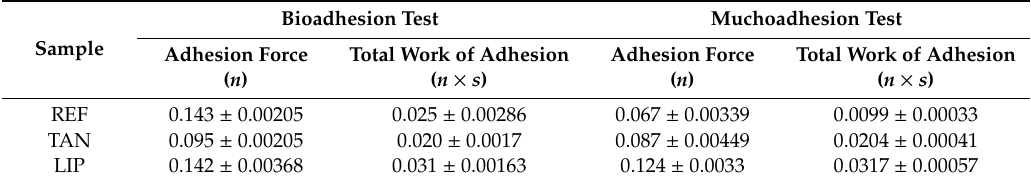
Table 3. Adhesive properties of the studied materials.